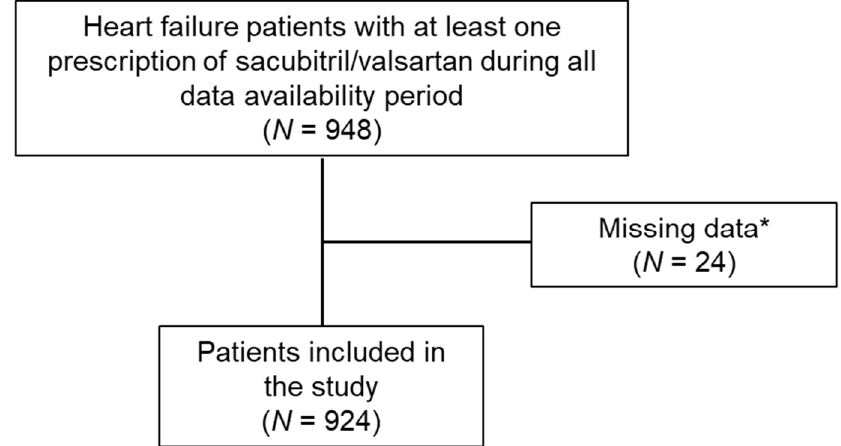
Figure 2. Flow chart of the study. * Patients with missing age or sex data and/or who did not have 6 months of characterization period and at least 12 months of follow-up available were excluded.